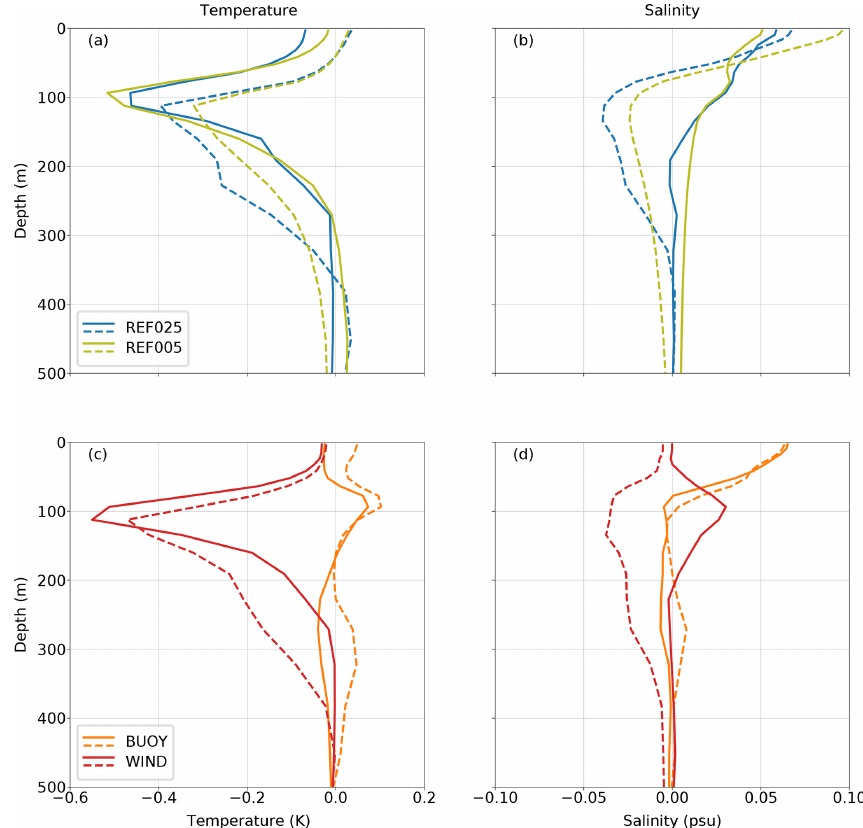
Figure 8. Linear regression of temperature and salinity to the Niño3.4 (solid) and PDO index (dashed) from (a, b) reference experiments and (c, d) sensitivity experiments. All data have been filtered with an 8-year low-pass